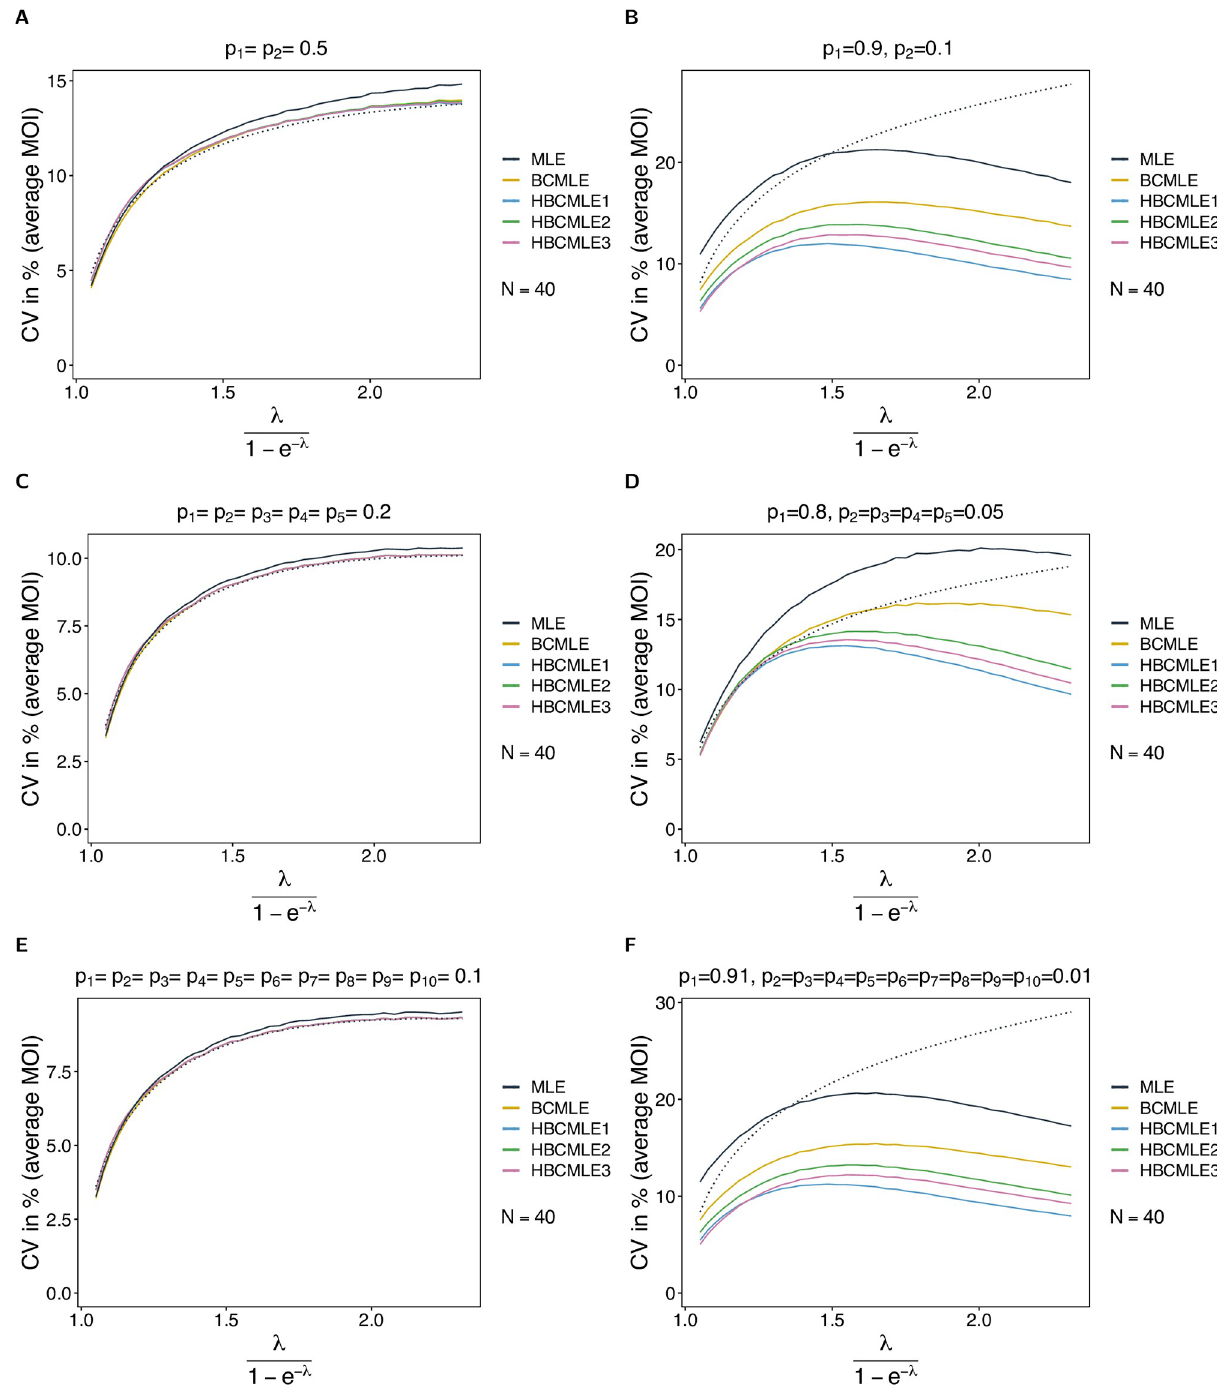
Fig 7. Variance of heuristically adjusted MOI estimators. Similar to Fig 6 but for the coefficient of variation in %. The dotted lines are the respective predictions based on the Crame´r-Rao lower bounds.